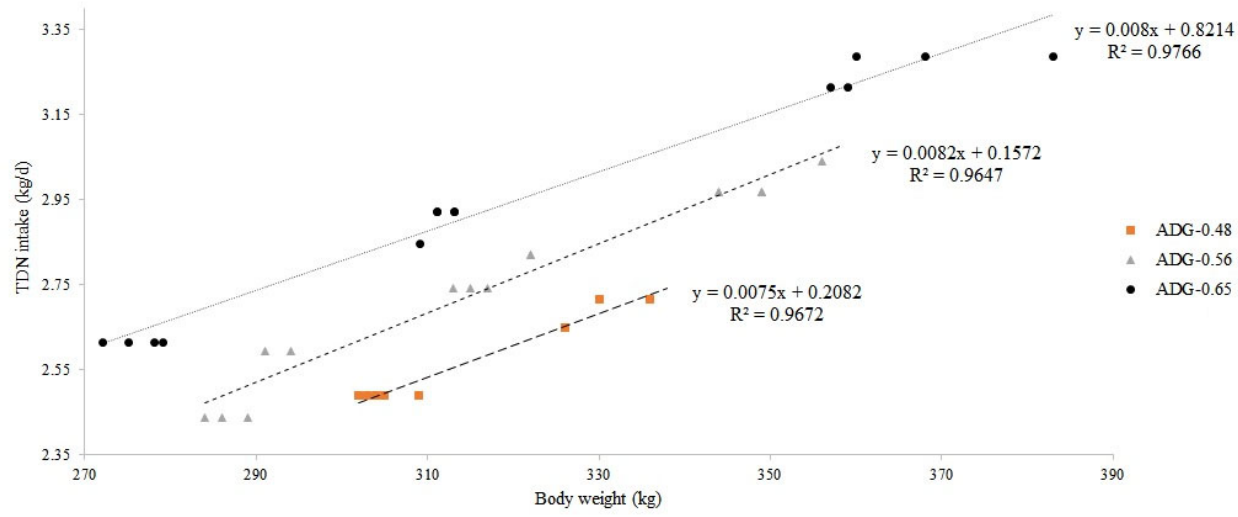
Figure 2. Regression equation for calculation of total digestible nutrient (TDN) requirements (kg/d) of Hanwoo heifers. ADG, average daily gain. ADG-0.48, y = 0.0075x+0.2082 (R 2 = 0.9672); ADG-0.56, y = 0.0082x+0.1572 (R 2 = 0.9647); ADG-0.65, y = 0.0080x+0.8214 (R 2 = 0.9766).